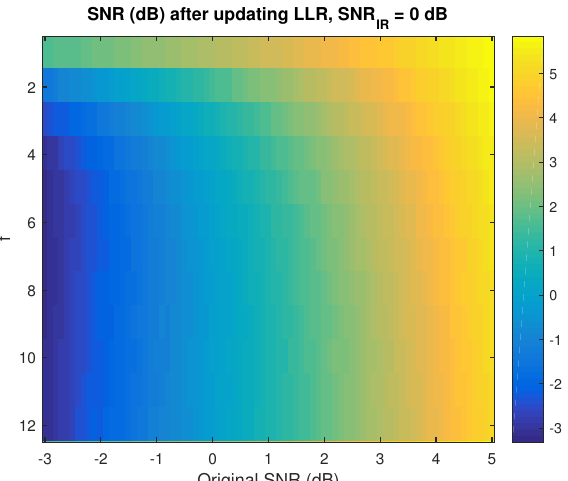
Figure 3. SNR after updating the log-likelihood ratios (LLRs) of f bits based on a transmission of their XOR with SNR IR = 0